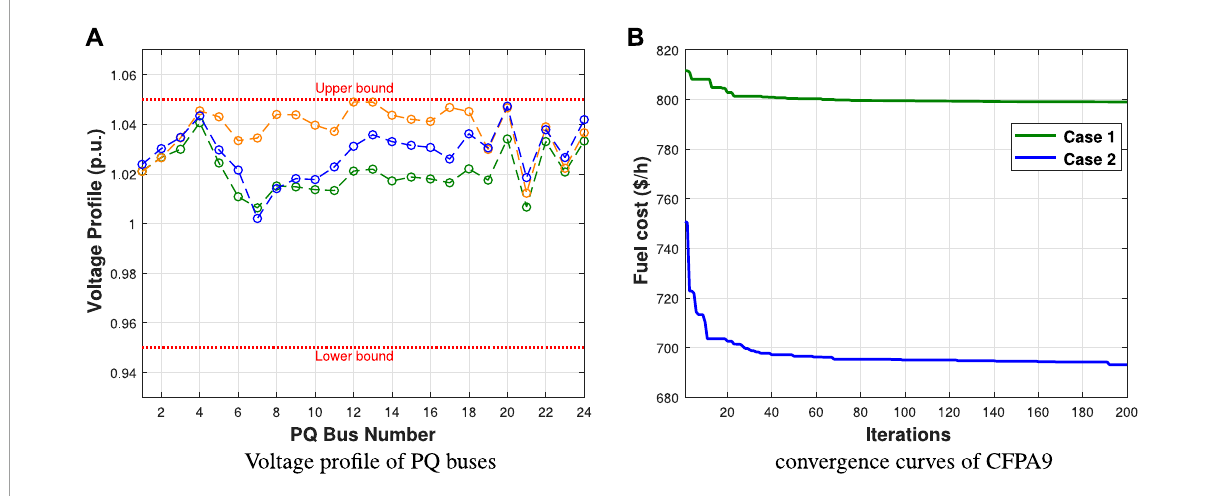
FIGURE 9 Voltage profile and convergence curves of CFPA9 for cases 1 and 2. (A) Voltage profile of PQ buses and (B) convergence curves of CFPA9.